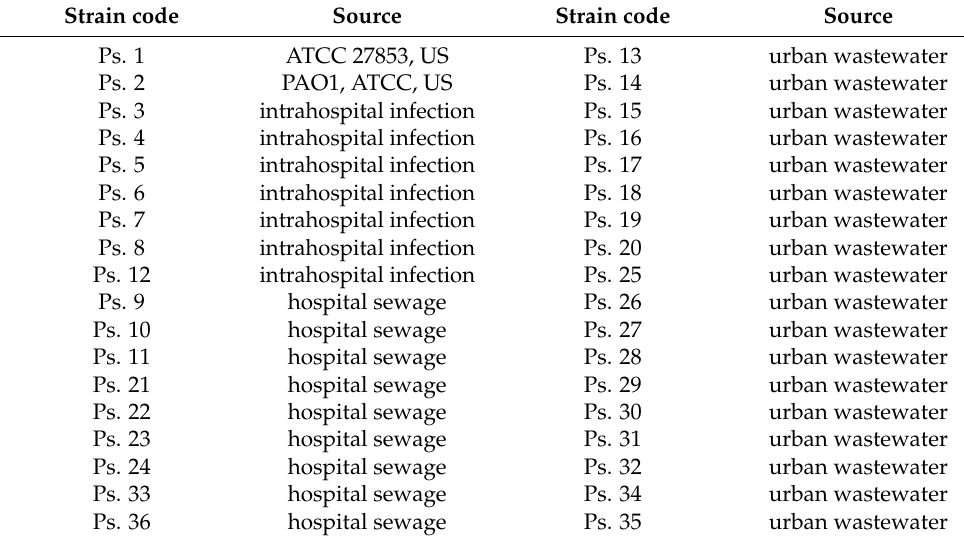
Table 1. P. aeruginosa strain codes and isolation sources. Strain